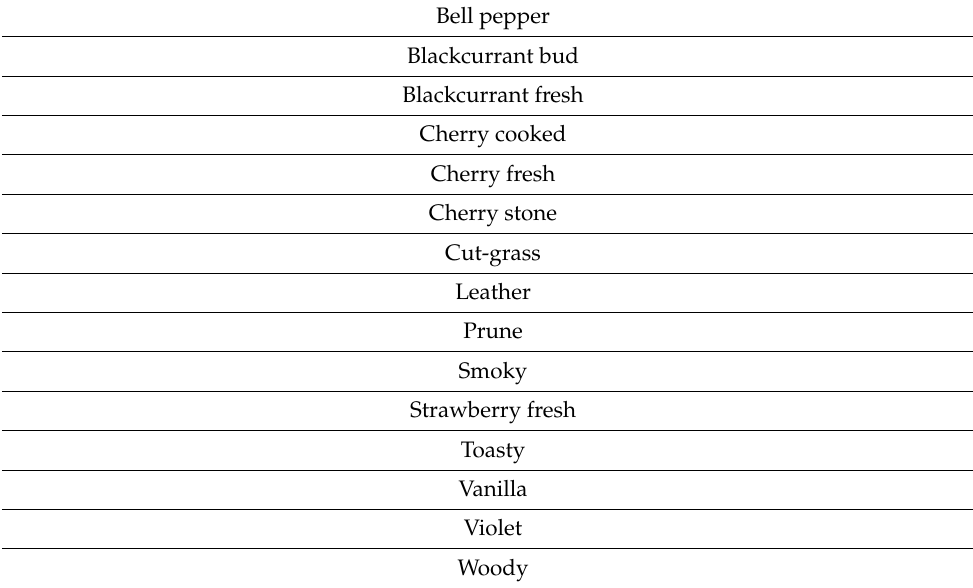
Table 1. List of the 15 odor sensory attributes